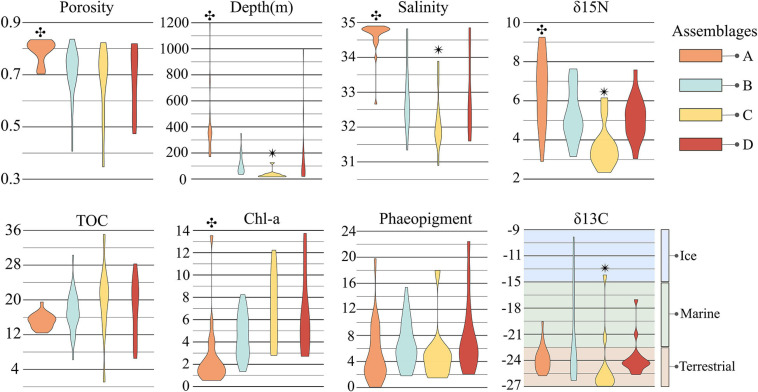
Distribution of environmental parameters for each assemblage. Each violin plot shows the distribution, within each assemblage, of the environmental parameters indicated as significant correlates in the ideal model for CAP analysis. Note that salinity is also included in this figure, though it was not run in CAP analysis due to the covariance inflation factor with depth. The symbols  and  indicate significant differences between un-matching symbols with other assemblages. δ13C values for ice, marine, and terrestrial OM sources was derived from Dunton et al. (2006).